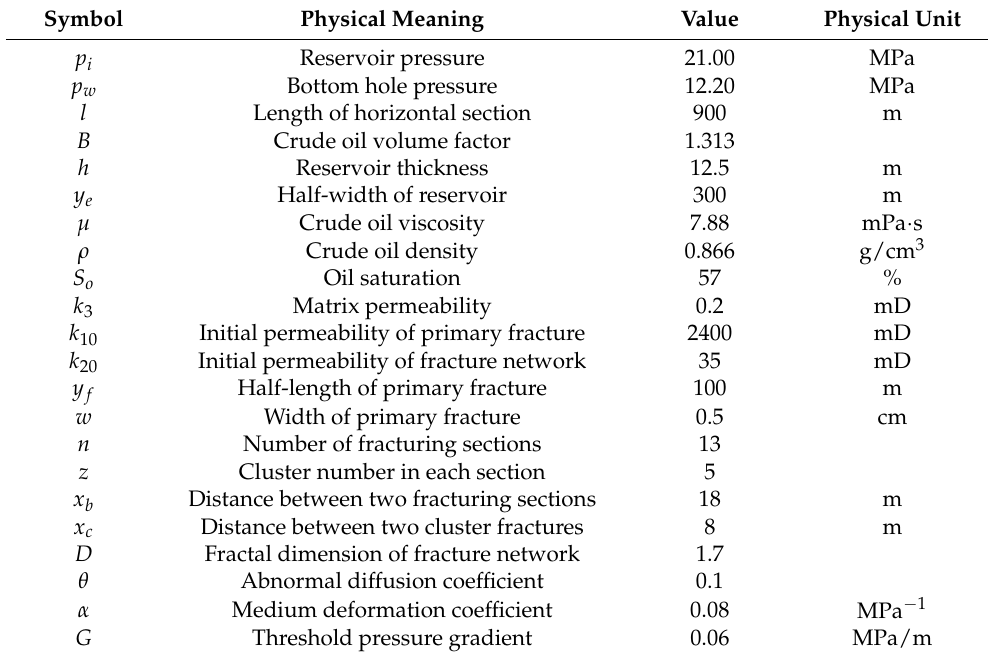
Table 1. Primary parameters of well A1 in block